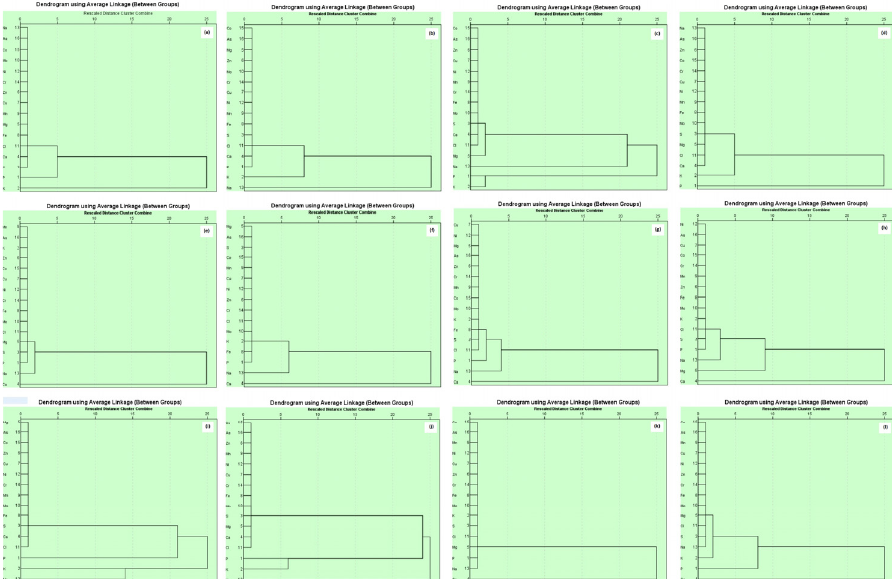
Figure 3. Hierarchical cluster analysis showing grouping of essential plant nutrients of different waste (( a ). brinjal waste, ( b ). potato peels, ( c ). banana peels, ( d ). orange peels, ( e ). eggshell, ( f ). cow bone, ( g ). chicken bone, ( h ). fish bone, ( i ). combined vegetable, ( j ). combined fruit, ( k ). combined animal, and ( l ). all